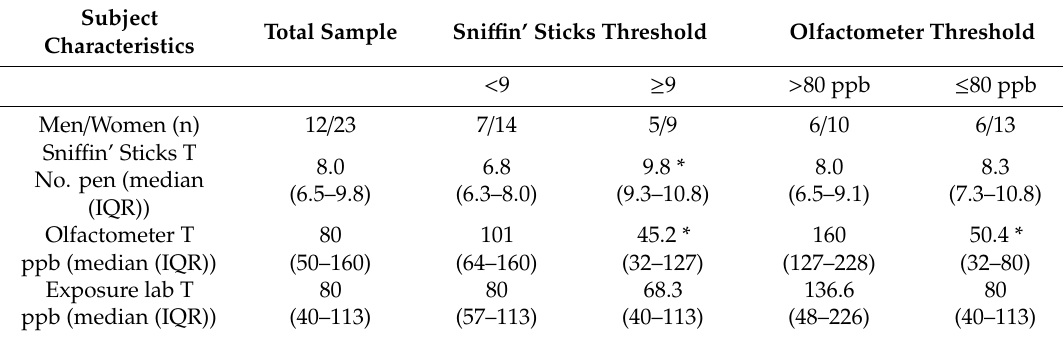
Table 2. Description of total sample and classified